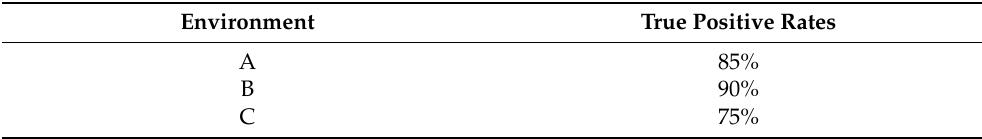
Figure 21. Fish detection using Mask R-CNN and length estimation results using the sonar camera system. Table 1. The true positive rate of Mask R-CNN for different experimental environments. Environment True Positive Rates A 85% B 90% C